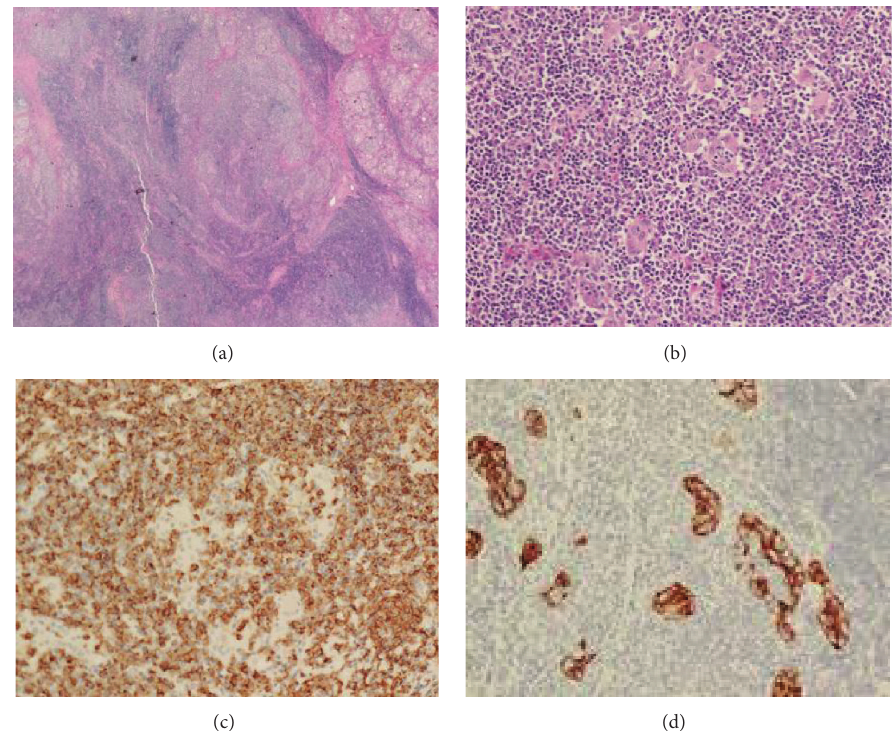
Figure 4: (a) Microscopic finding shows the extranodal marginal zone lymphoma of MALT in a background of Hashimoto’s thyroiditis (H&E stain, × 20). (b) Microscopic finding of the thyroid mass shows marked lymphocytic infiltration and a few degenerated follicles (H&E stain, × 200). (c) Immunohistochemical findings disclose diffuse positive staining for CD20 (immunohistochemistry, × 200). (d) Immunostaining for cytokeratin highlights lymphoepithelial lesions (immunohistochemistry, ×